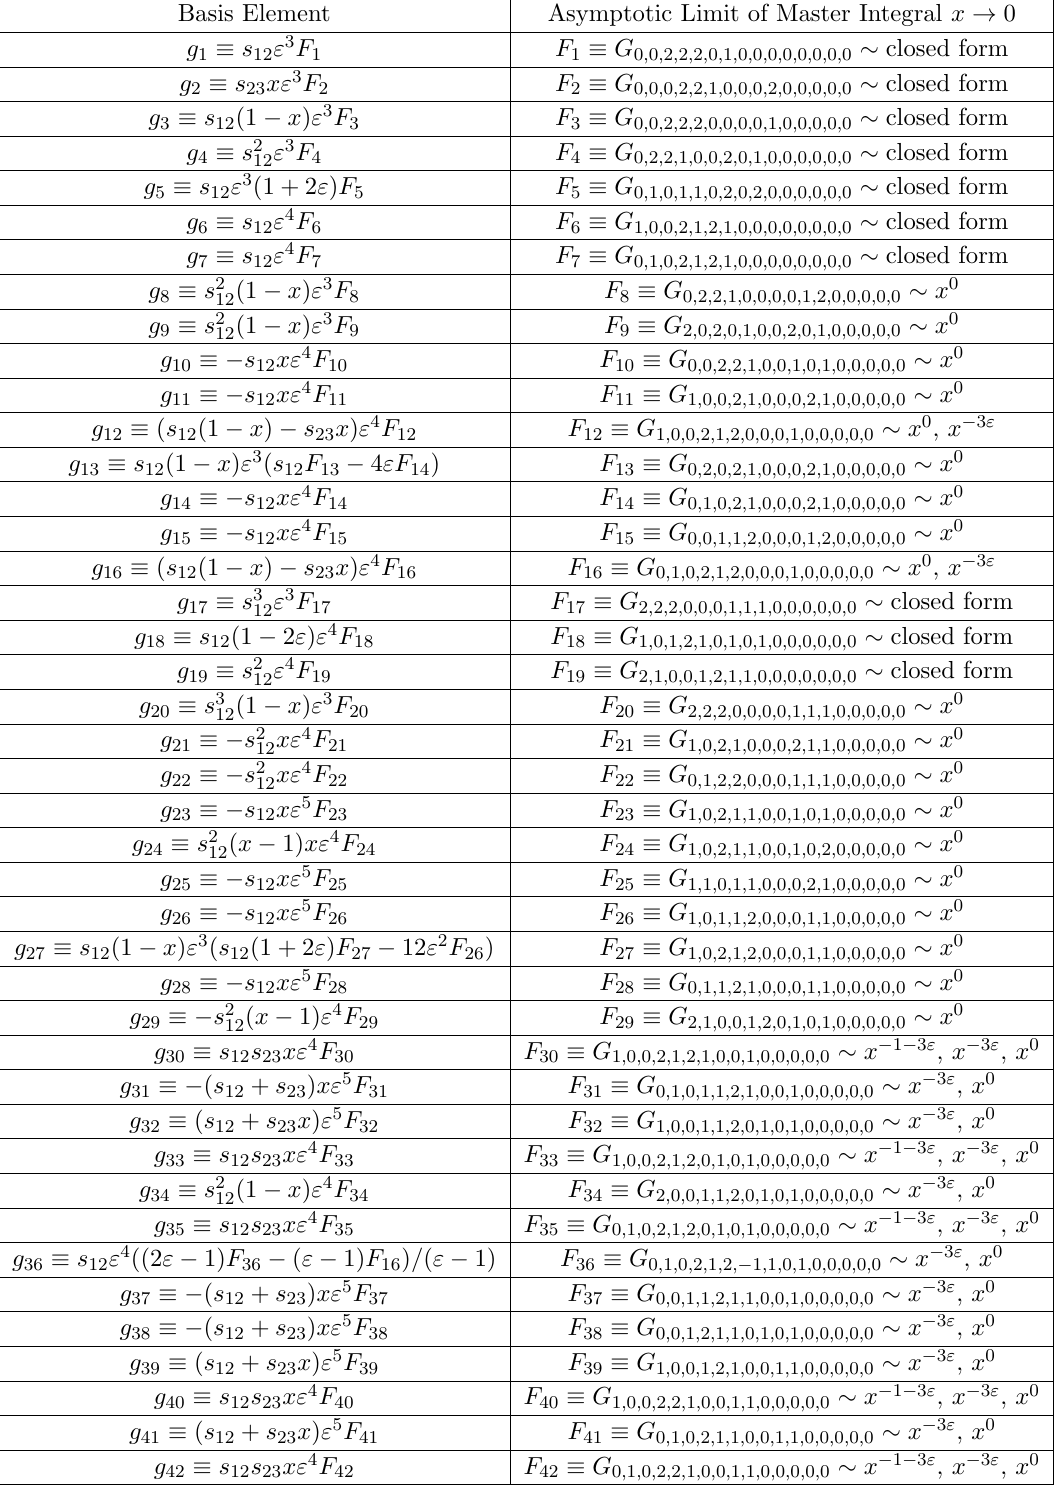
Table 1 . The (cid:12)rst 42 U.T. basis elements of the basis presented in [35] written in the SDE notation.